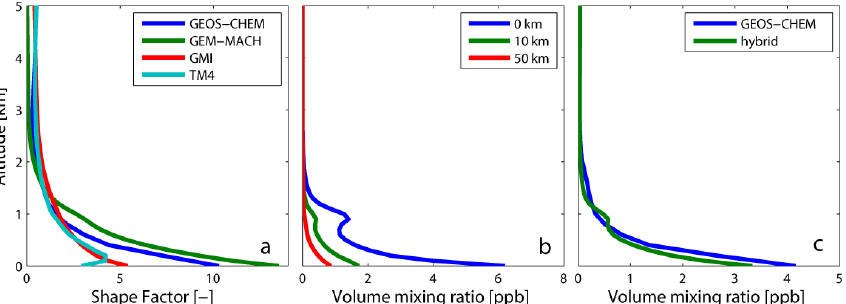
Fig. 2. Comparison of annual-mean model NO 2 profiles over the oil sands (sampled at the local time of the OMI overpass, ∼ 13:30LST): (a) TM4, GMI, GEOS-CHEM, and GEM-MACH shape factors each at a resolution of roughly 200km(N–S) x 150km(E–W); (b) GEM- MACH volume mixing ratio profiles (at its native 15 × 15km 2 resolution) at distances of 0, 10, and 50km from the reference location; and (c) GEOS-CHEM and the GEOS-CHEM + GEM-MACH hybrid (see text) volume mixing ratio profiles over the surface mines at a resolution of 0.5 ◦ × 0.67 ◦